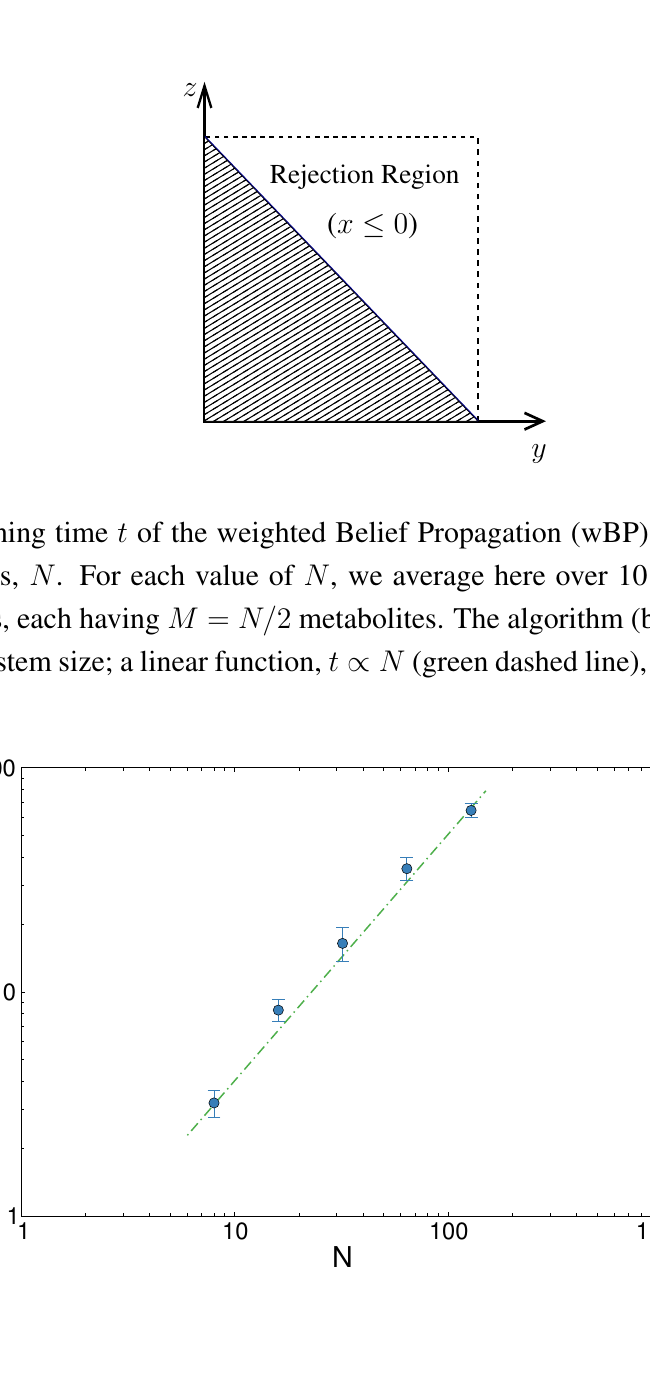
( y ) φ ( z ) , is no longer normalised. This is easily dealt y z